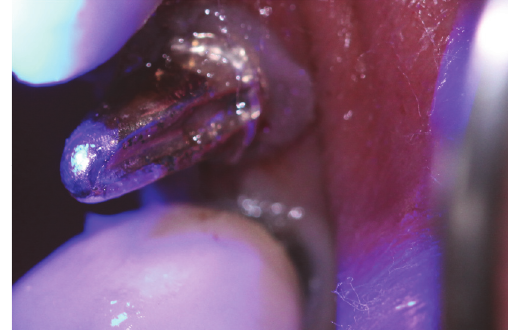
Figure 7: Framework sealing and adaptation of metal crown.